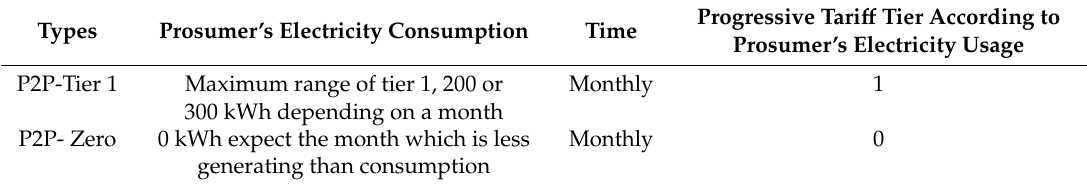
Table 9. Trading types depending on the energy consumption